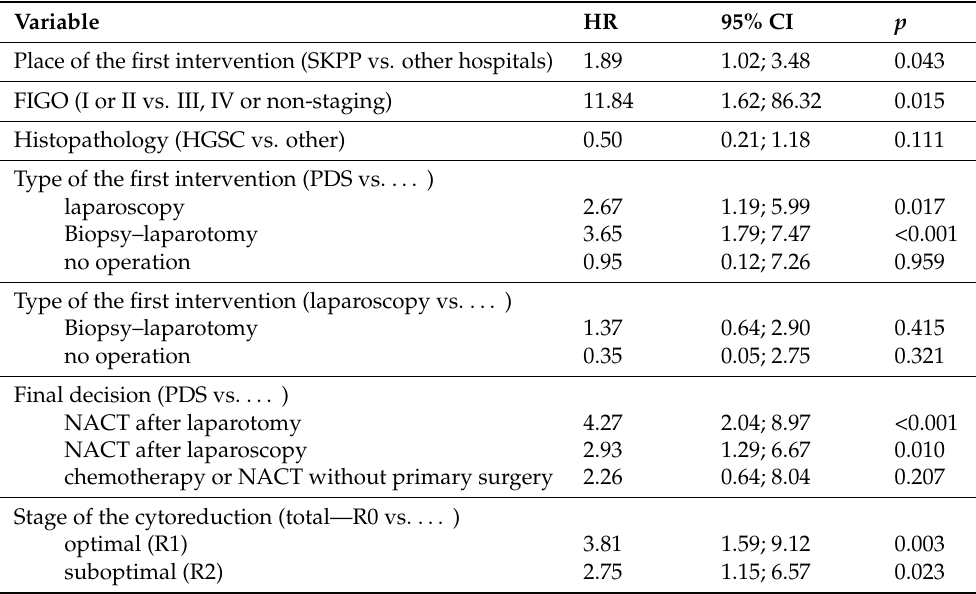
FIGO—the International Federation of Gynaecology and Obstetrics; HGSC—high-grade serous carcinoma; PDS—primary debulking surgery; NACT—neoadjuvant chemotherapy; LAP—laparoscopy; p — p -value; HR—hazard ratio; HR with a 95% CI—hazard ratio with a 95% confidence interval for the occurrence of relapse.